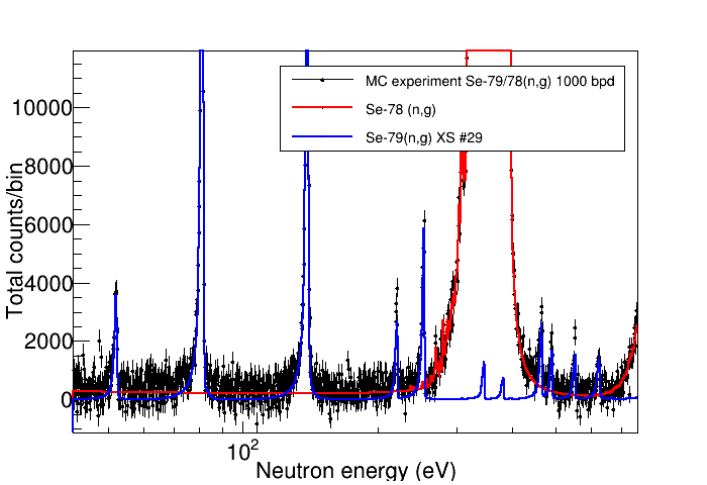
Figure 6. Total expected counts of 78 Se + 79 Se(n, γ ) for the experiment at CERN n_TOF illustrating the feasibility to identify 79 Se